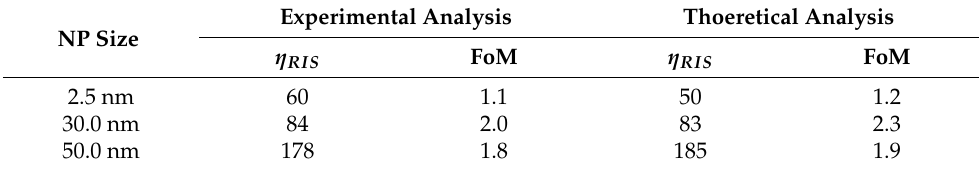
Table 1. Reported research on η RIS (nmRIU − 1 ) and FoM using size-dependent